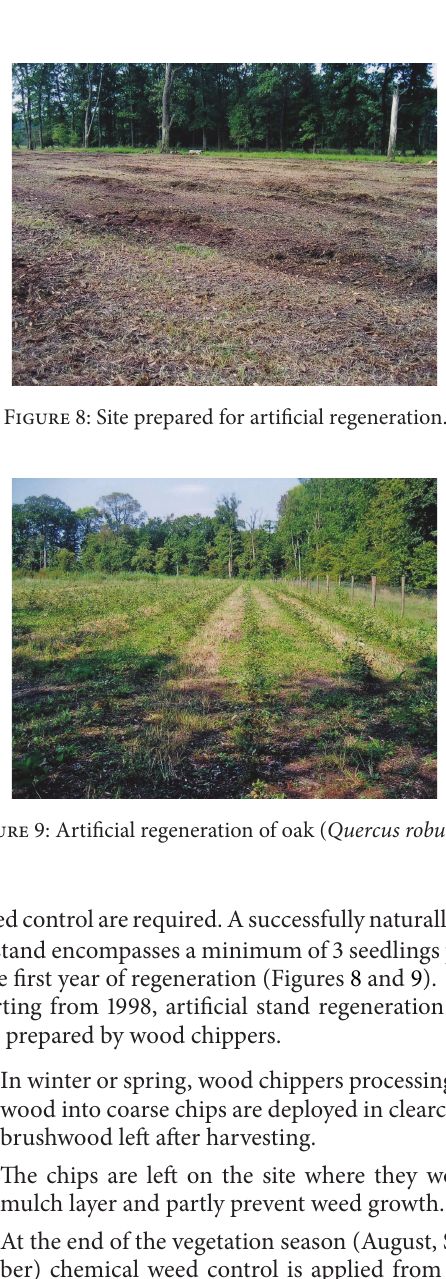
Figure 5: Wetland restoration: tree vegetation formed during the period of 1982–1990 (South Moravia).